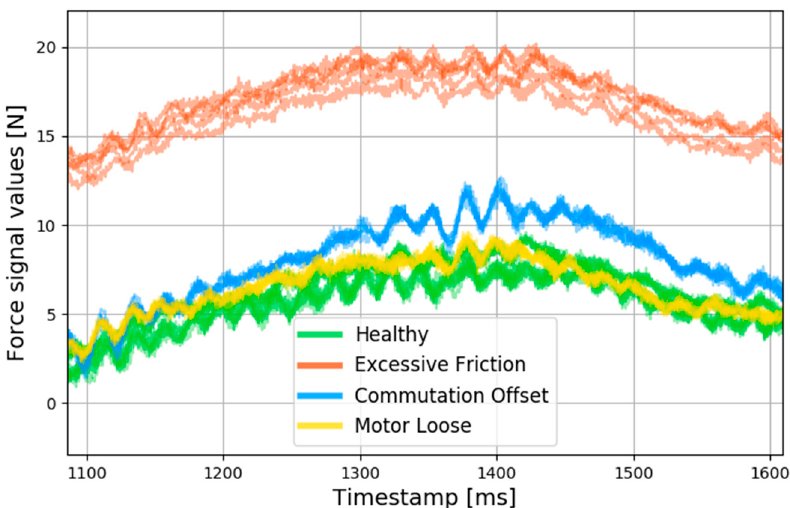
Figure 3. Zoom on region of interest (ROI) 2 displaying the characteristic behaviour of the different healthy and faulty conditions during constant velocity travel in (+) direction.